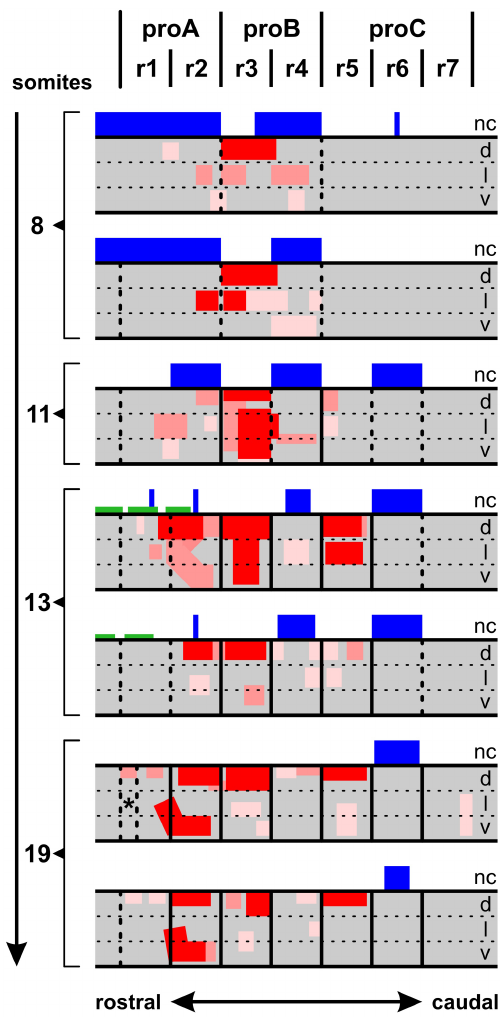
Figure 17. Segment-specific patterns of cell death and neural crest delamination in the developing hindbrain of Tupaia belan- geri . Schemes were created from 3-D reconstructed embryos of 8 to 19 pairs of somites and show lateral views of the neuroep- ithelial walls (gray). Red, medium red, and light red: high, mod- erate, and low amounts of apoptotic cells, respectively; blue, de- laminating neural crest cells (nc). Rhombomeres r1–r7 (dotted line: developing boundary; continuous line: well-demarcated boundary) develop from three pro-rhombomeres (proA, proB, proC) and are subdivided in dorsal (d), lateral (l), and ventral (v) thirds. Neural crest delamination in the even-numbered r2, r4, and r6 and apop- tosis in the odd-numbered r3 and r5 (dorsal apoptotic maxima and transverse apoptotic bands) proceed rostrocaudally. Note the curved apoptotic band and the dorsal apoptotic maximum in r2. Aster- isk, “rhombomere 0”; green, ventricular protrusion of fusing neural folds. Reproduced from Knabe et al. (2004b, Fig. 6). © Springer- Verlag 2004, with kind permission from Springer Science and Busi- ness